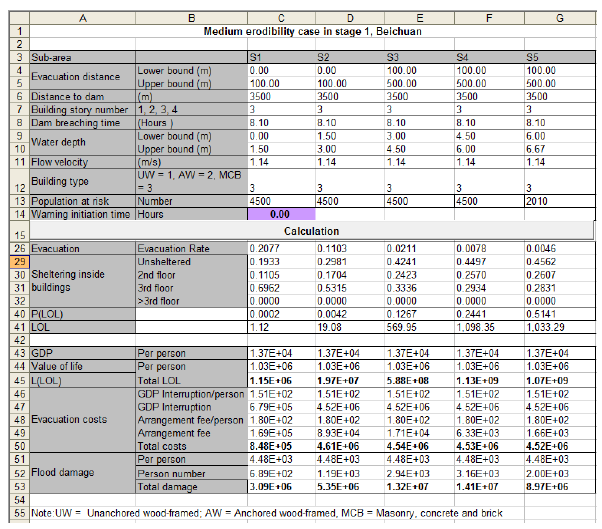
Fig. 12. Evaluation of flood consequences in Beichuan Town in the medium erodibility case in stage 1